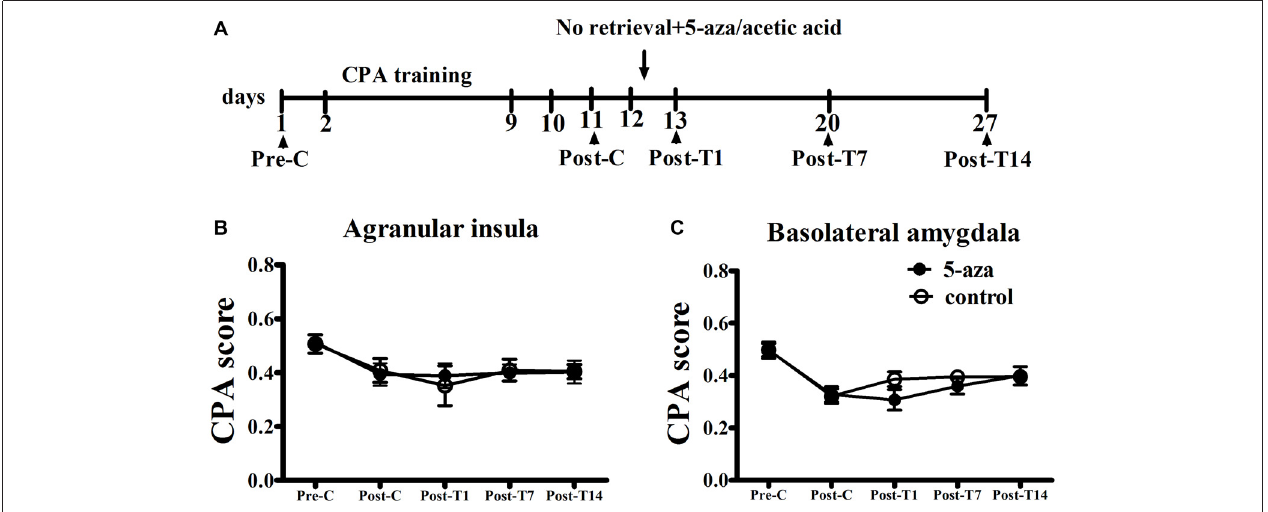
FIGURE 4 | Effects of microinjection of 5-aza into AI and BLA on morphine-withdrawal memories without exposure to conditioning chamber. (A) Timeline of experimental procedure (B) 5-aza injection into AI without memory reactivation had no effect on CPA. (C) Injection of 5-aza into BLA without memory retrieval had no effect on CPA. Data are presented as mean ±